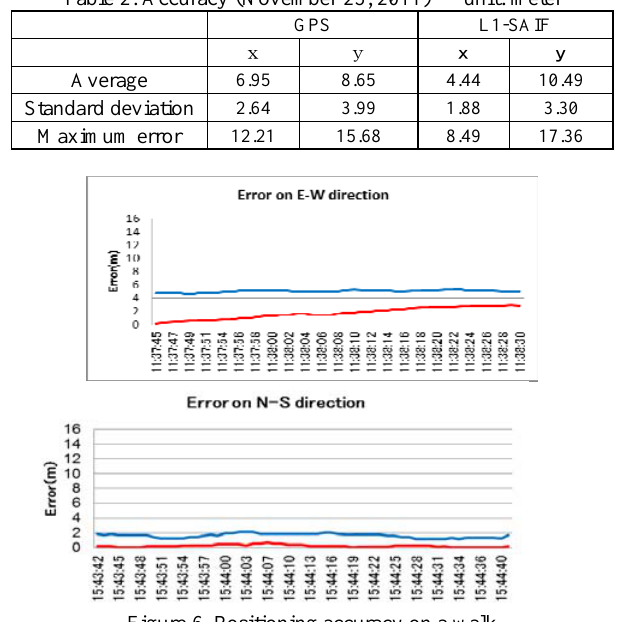
Figure 6. Positioning accuracy on a walk (Blue: GPS, Red: QZS1